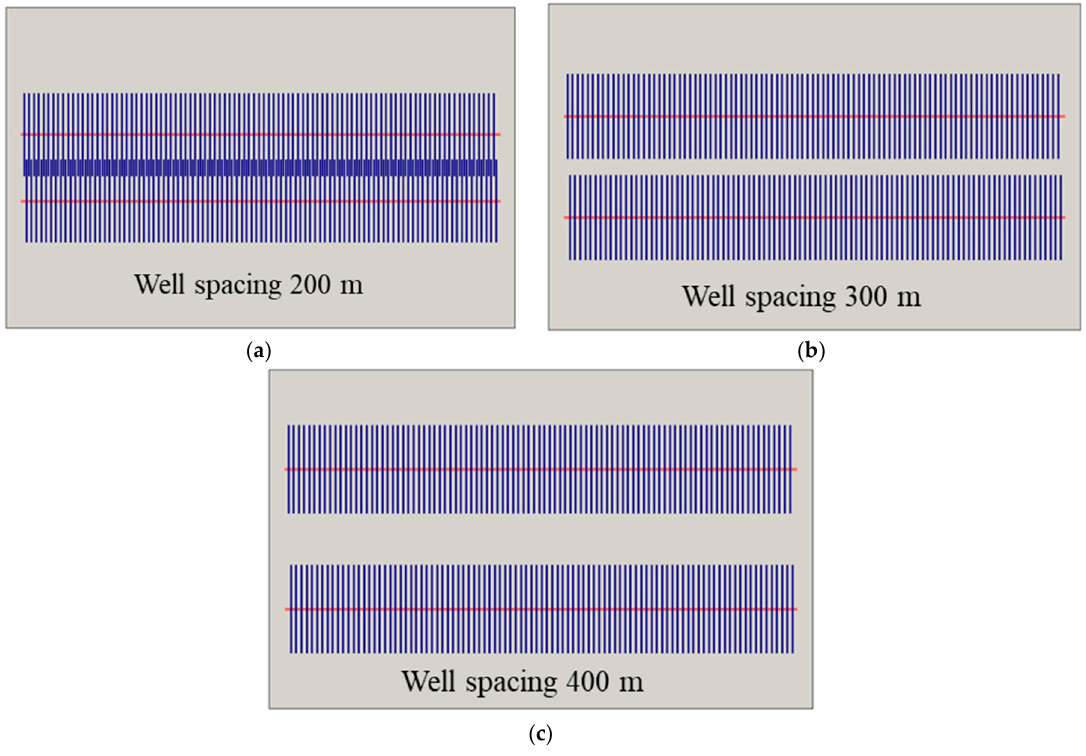
Figure 6. The basic reservoir simulation model including two horizontal wells and 97 hydraulic fractures for each well: ( a ) Well spacing of 200 m; ( b ) Well spacing of 300 m; ( c ) Well spacing of 400 m.